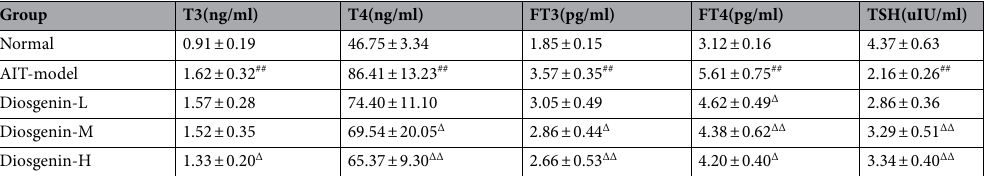
Table 1. Comparison of serum results of thyroid function ( ¯ x ± SD , n = 10). Note: # Compared with normal group, P < 0.05; ## Compared with the normal group, P < 0.01; Δ Compared with the model group, P < 0.05; ΔΔ Compared with the model group, P < 0.01.